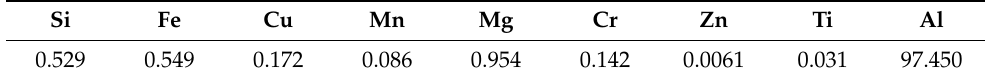
Table 1. Chemical composition of Al6061 alloy